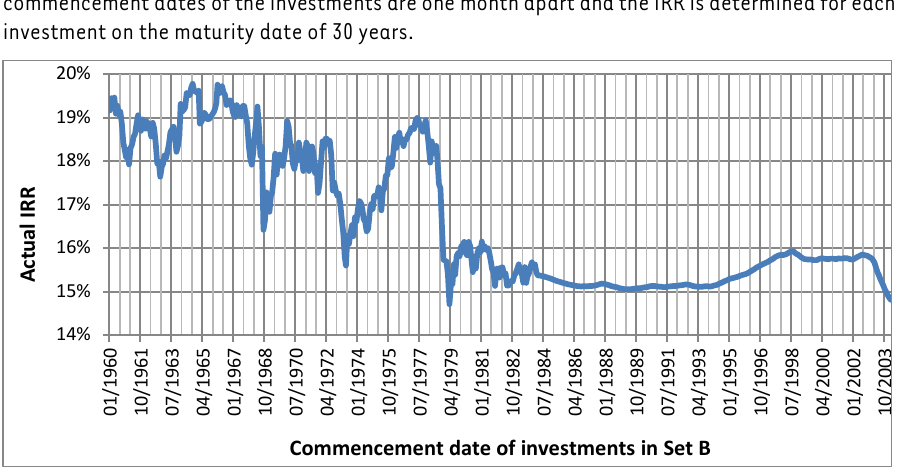
FIGURE 4: IRRs generated by the monthly investments of Set B Source: Authors’